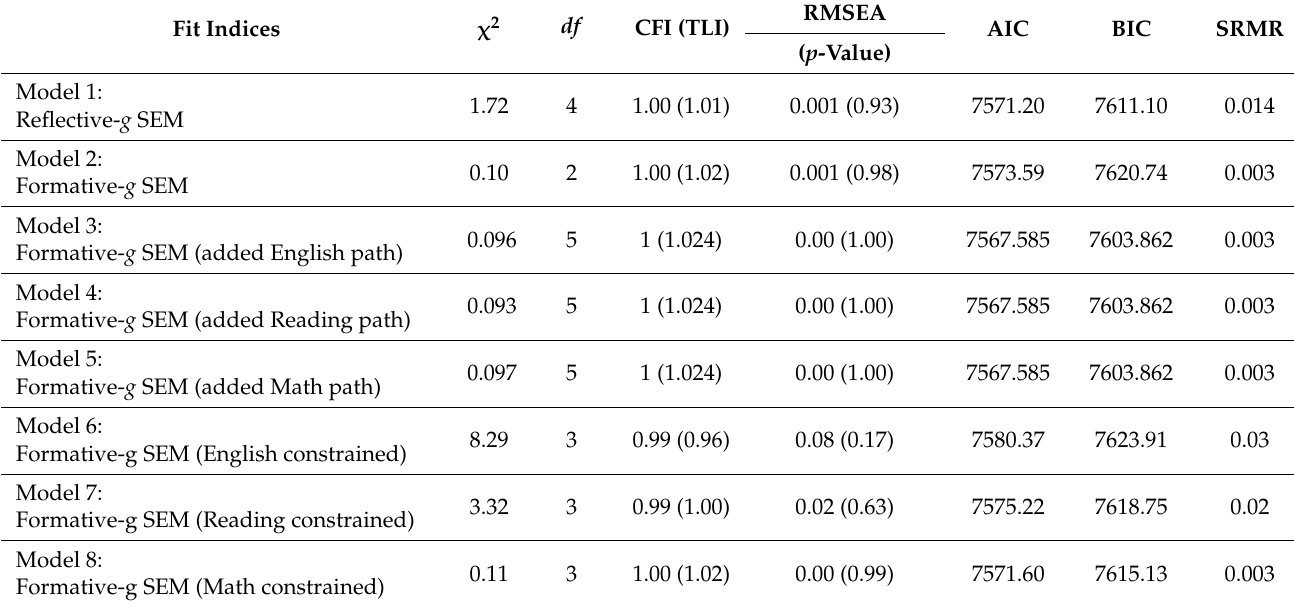
Table 3. Model Fit Indices for the main models (Model 1 and Model 2) as well as for the additional models. Models 6–8 are described in Appendix